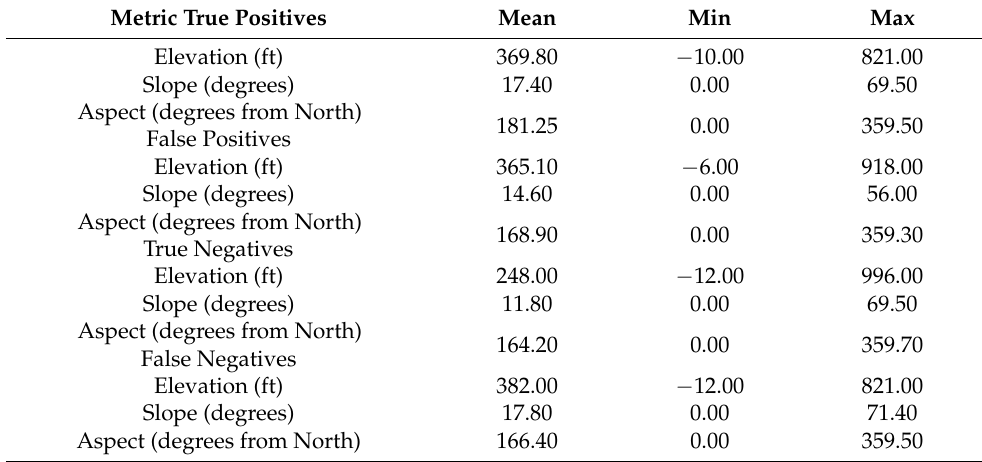
Table 6. Topography summary statistics by prediction class for U-Net_CZU_3.